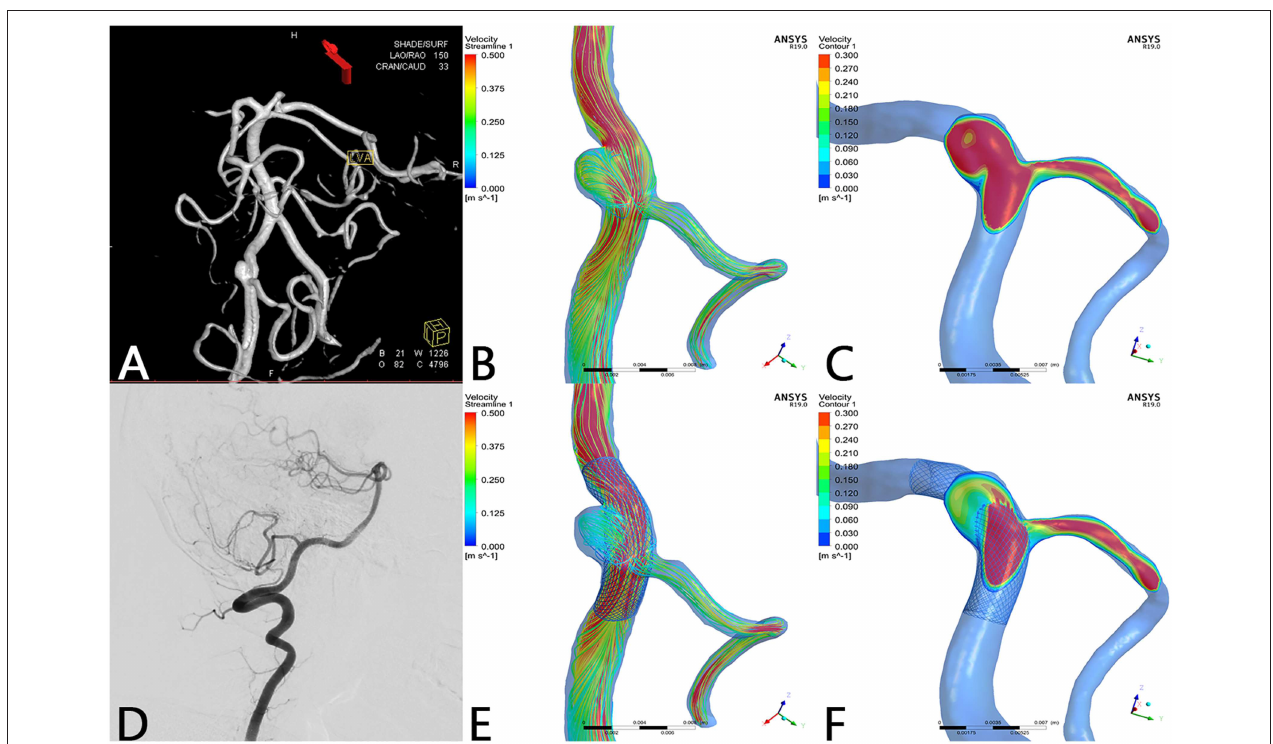
FIGURE 1 | Case of a left vertebral artery aneurysm treated by a PED. (A) Left vertebral artery angiogram showing a V3 segment aneurysm. (B) Preoperative streamline of aneurysm and PICA. (C) Preoperative velocity contour of aneurysm and PICA. (D) Angiogram at 7-month follow-up showed that the aneurysm reached complete occlusion with patency of PICA. (E) Postoperative streamline of aneurysm and PICA. The streamline in the aneurysm became sparser compared with preoperatively. However, the streamline in PICA remained nearly unchanged compared with (B) . (F) Post-operative velocity contour of aneurysm and PICA. Compared with (C) , flow velocity in the aneurysm slowed down markedly, whereas flow velocity in the PICA merely decreased slightly at